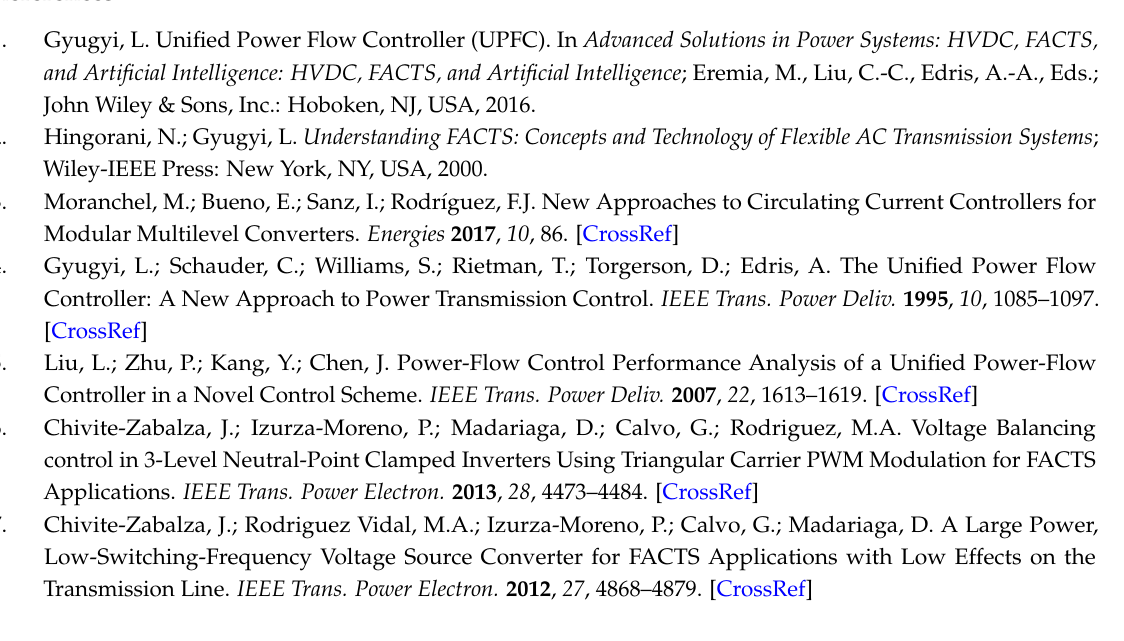
Figure 12. The experimental setup using the DMC based UPFC.